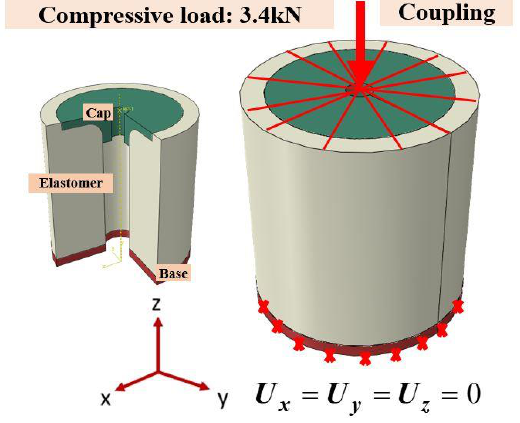
Figure 8. Boundary conditions and applied loads.